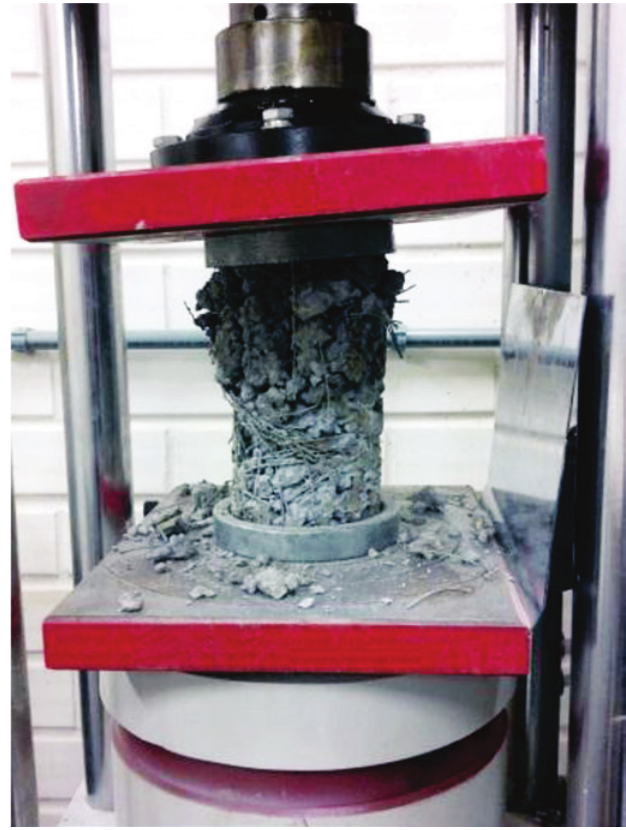
Figure 6 Rupture under axial compression of pervious concrete with